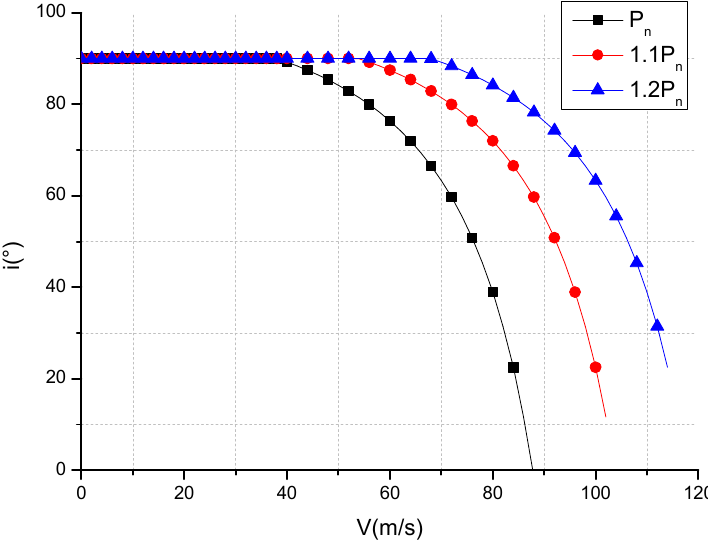
Figure 14. The influence of available power on flight corridors.